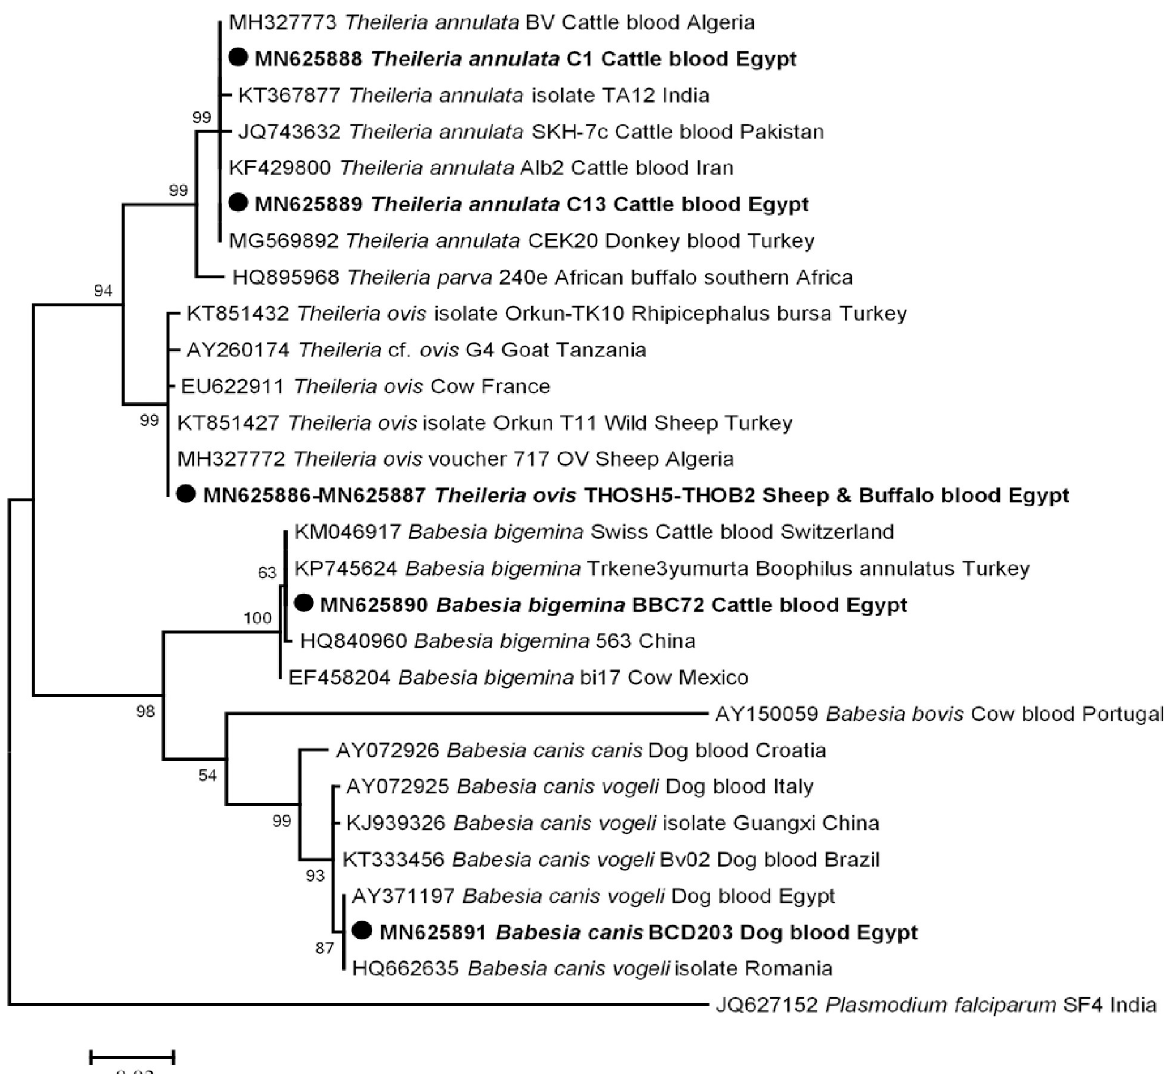
Fig 2. 18S rRNA based phylogenetic analysis of genotypes identified in this study. Phylogenetic tree highlighting the position of Theileria sp. and Babesia sp. in the present study ( Bold ) related to other Theileria sp. and Babesia sp. available in GenBank. The sequence of 18S rRNA were aligned using CLUSTAL W and phylogenetic inferences were constructed in MEGA X using Maximum Likelihood based on Tamura-Nei Model for nucleotide sequences with 500 bootstrap replicates. There was a total of 1066 positions in the final dataset. The scale bar represents a 2% nucleotide sequence